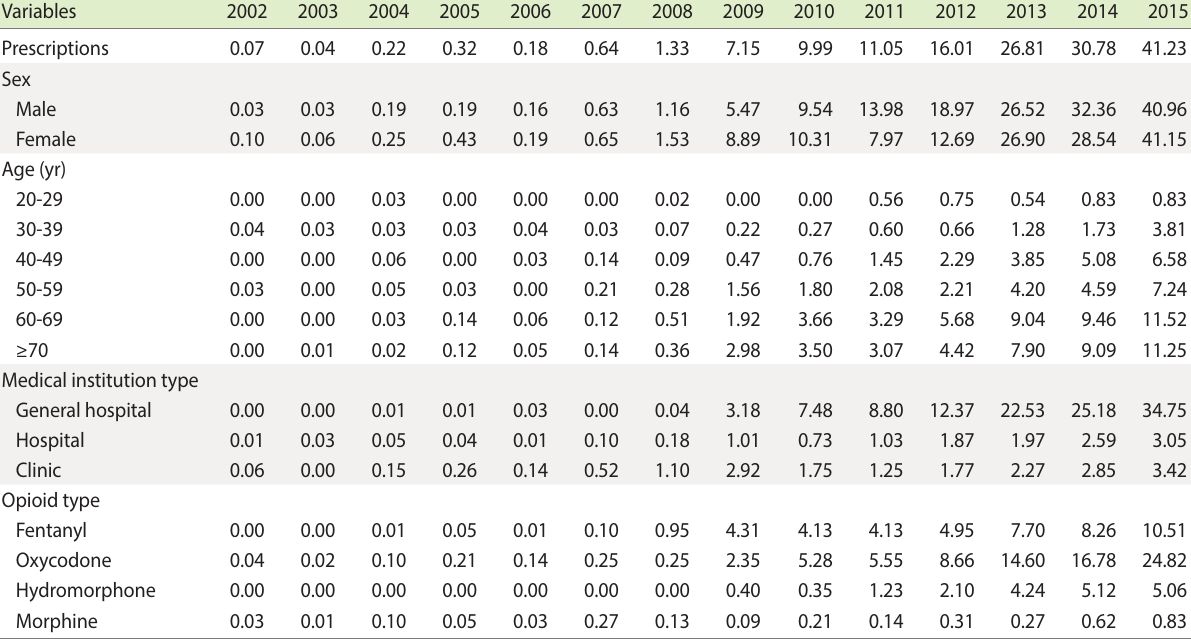
Table 2. The age-standardized number of annual opioid prescriptions as cases per 10,000 registrants during 2002-2015